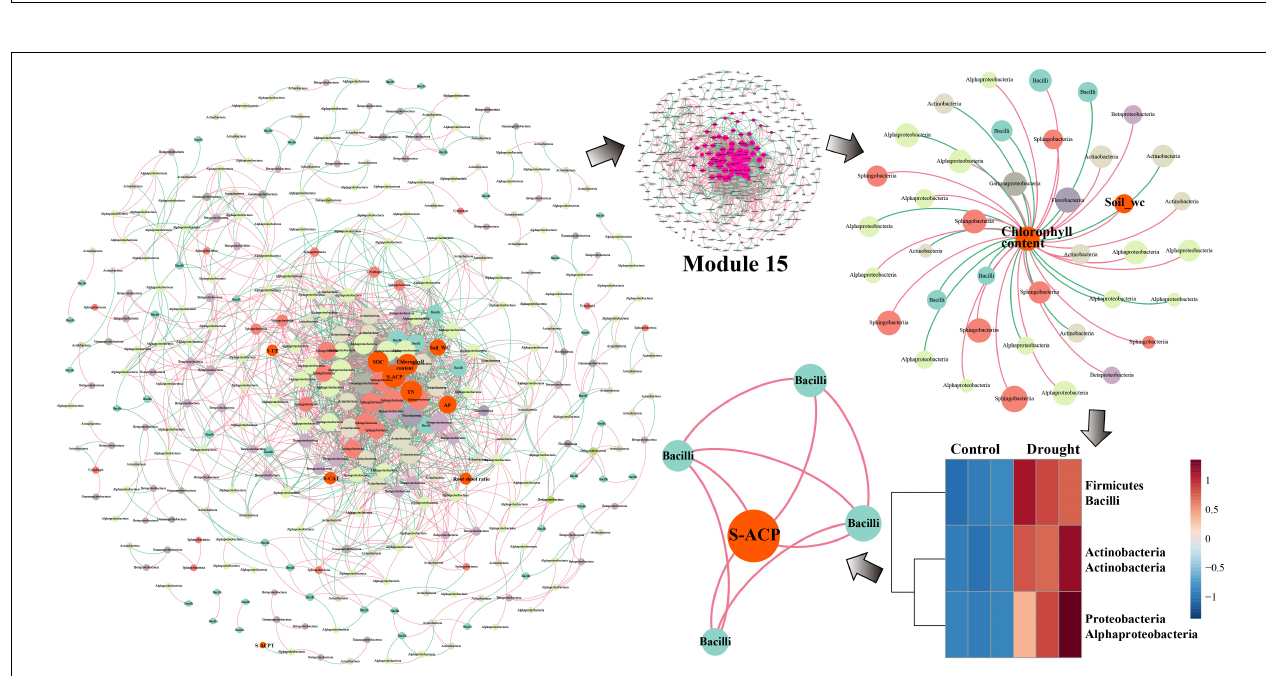
FIGURE 5 | The network analysis of MENA shows that there is a significant interaction between the rhizobacteria community OUT under normal water and drought stress in the sugarcane variety GT39. The node indicates that the bacteria OUT in the microbial network with significant interactions are determined by the degree of connection. It is colored according to the system-level classification membership. The red line connecting the nodes indicates positive interaction, and the green line indicates negative interaction. Among them, GT39 (drought sensitive) mainly depends on Actinobacteria flora in response to drought stress Groups are closely related to S-ACP and S-ACPT.